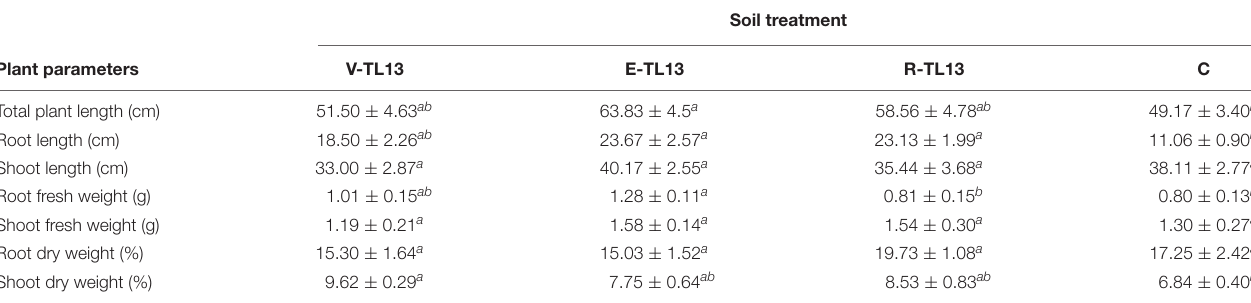
TABLE 4 | Effect of different inoculant formulations on total plant length (cm), root length (cm), shoot length (cm), root fresh weight (g), shoot fresh weight (g), root dry weight (%), shoot dry weight (%) of maize